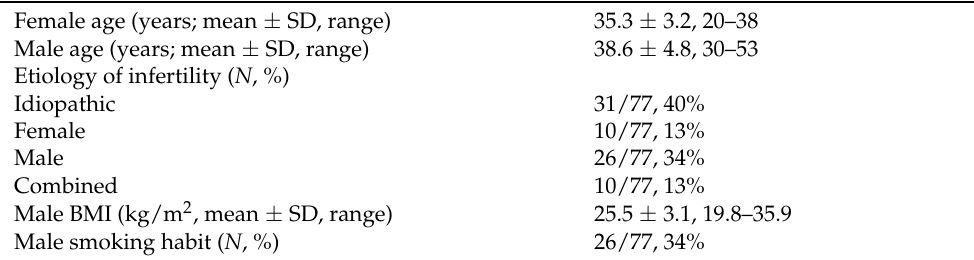
Table 1. Baseline demographic and fertility characteristics of the 77 couples included in the study. Female age (years; mean ± SD, range) Male age (years; mean ± SD, range) Idiopathic Female Male 26/77, 34% Combined 10/77, 13% Male BMI (kg/m 2 , mean ± SD, range) 25.5 ± 3.1, 19.8–35.9 Male smoking habit ( N , %) 26/77, 34% SD, standard deviation; BMI, body max